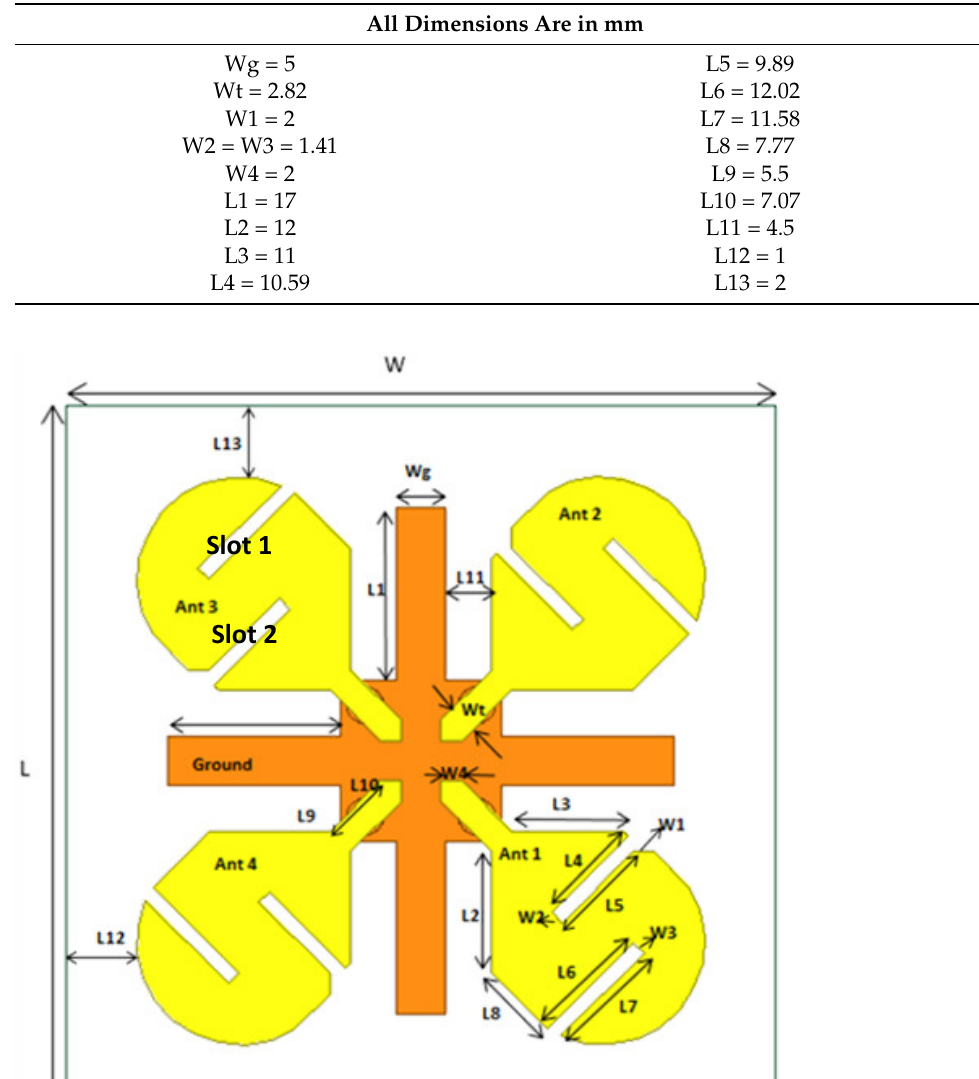
Table 1. Parameters of the dual-band multiple-input and multiple-output (MIMO) antenna.